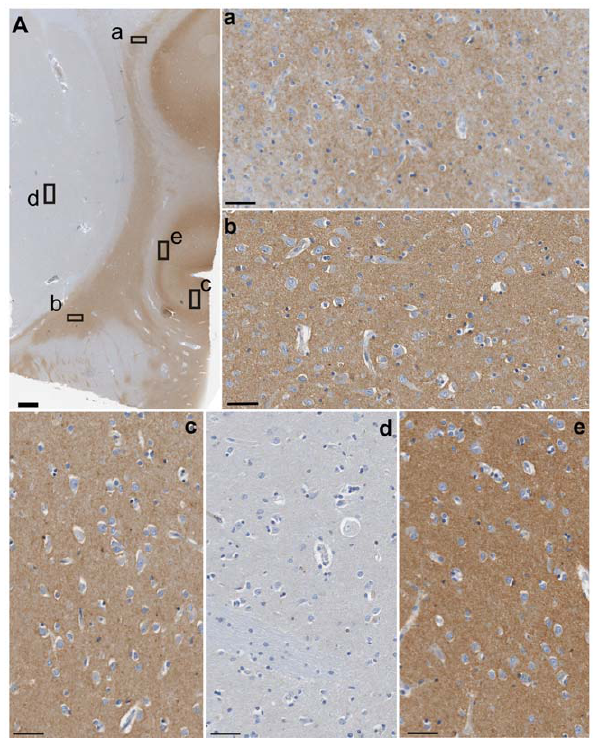
Figure 2. Gng2-ir distribution in the claustrum and adjacent structures. (A) Low magnification image. (a–e) Higher magnification images of A correspond to the dorsal claustrum (a), the ventral claustrum (b), the insular cortex (c), the putamen (d) and the VI layer of the insula (e). Scale bar =1 mm (A), 50 m m (a–e).